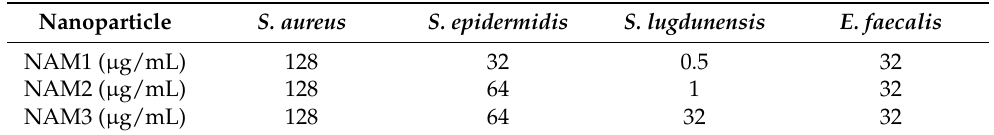
Table 1. Minimal inhibitory concentrations (MICs) of NAM1, NAM2 and NAM3 against S . aureus , S . epidermidis , S . lugdunensis and E . faecalis .